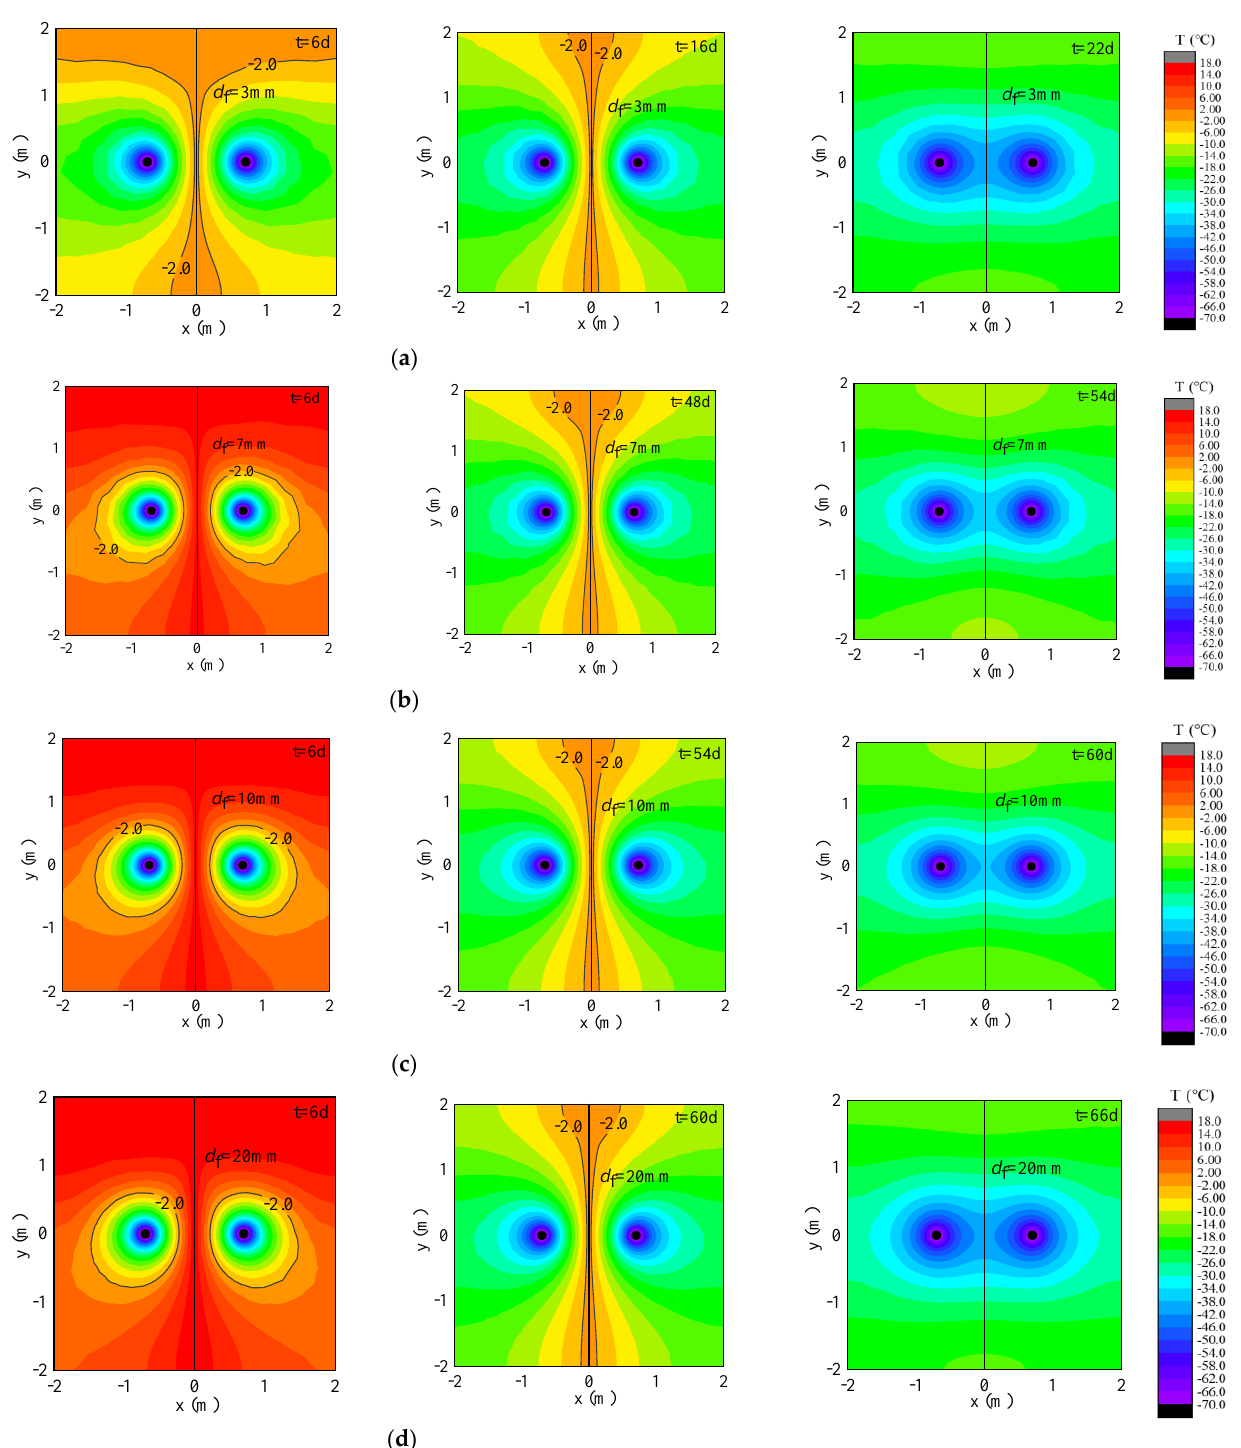
Figure 14. Interfacial temperature distributions of single-fractured porous media rock mass with different fracture apertures during the liquid nitrogen reinforcement freezing process: ( a ) d f = 3 mm; ( b ) d f = 7 mm; ( c ) d f = 10 mm; ( d ) d f = 20 mm.